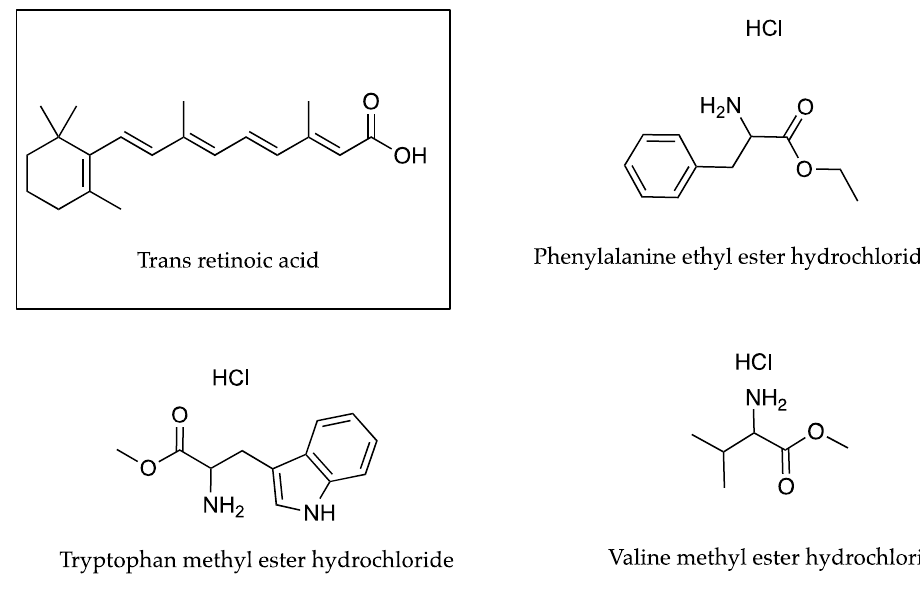
Figure 6. RA and phenylalanine ethyl ester hydrochloride, tryptophan methyl ester hydrochloride and valine methyl ester hydrochloride.